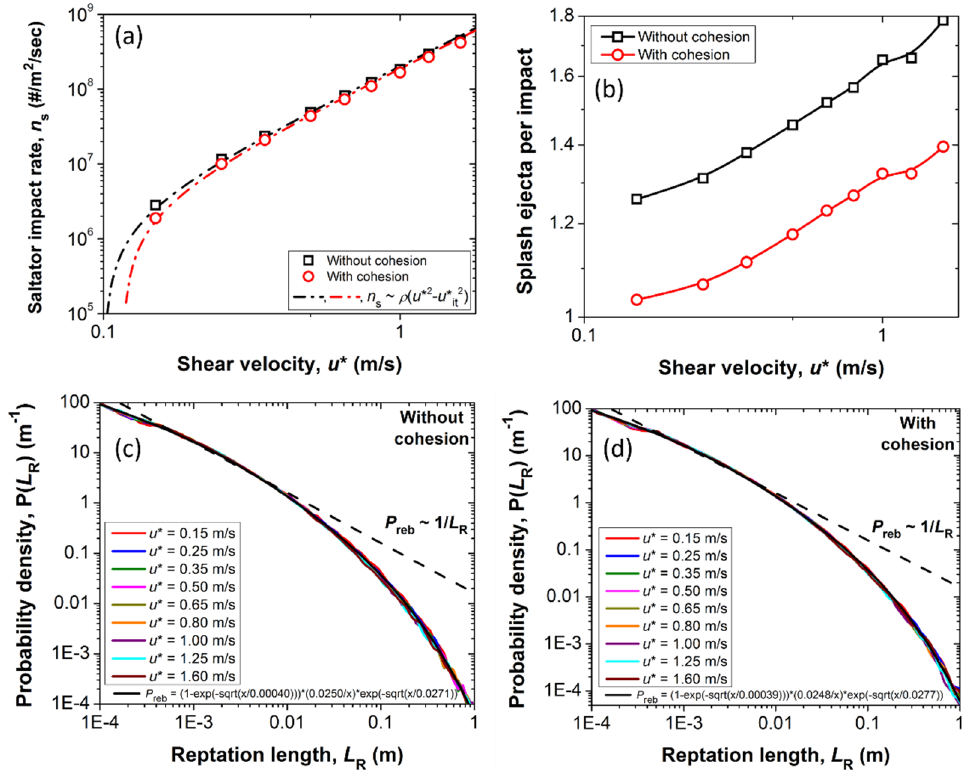
Figure 3. The parameters supplied to the model from COMSALT calculations. ( a ) The saltator impact rate 𝑁 𝑖𝑚 0 on a flat surface for different shear velocities and for 100 μ m grain diameter calculated using COMSALT with and without cohesion. The impact rate increases with the shear velocity. ( b ) The average number of ejected particles per impact of saltating grains ( n ) for different shear velocities. COMSALT simulations for the probability distribution of reptation lengths for transport of 100 μ m particles at different shear velocities without cohesion ( c ) and with cohesion ( d ). The probability distribution of reptation lengths depends very weakly on the shear velocity.